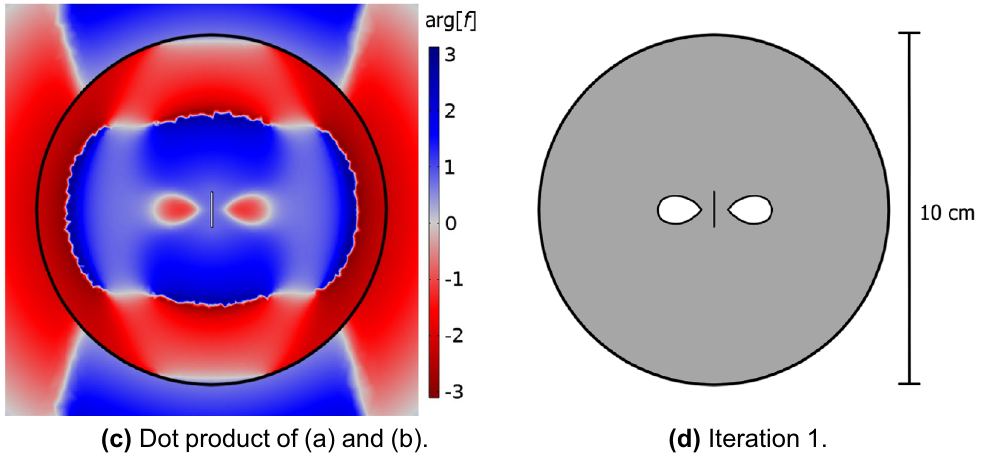
Figure 1. ( a ) and ( b ) show the result of Eq. 3 (left) and magnitude (right) of the numerically modelled electric fields at 2.00 GHz for a 1 cm dipole, radiating into free space, and that same dipole embedded in a 5 cm radius dielectric sphere of relative permittivity ( ε r = 12 ) respectively. ( c ) displays arg[ f ], calculated using Eq. 3. ( d ) is the first iteration in the design process, informed by ( c ). Each image is displayed on the same